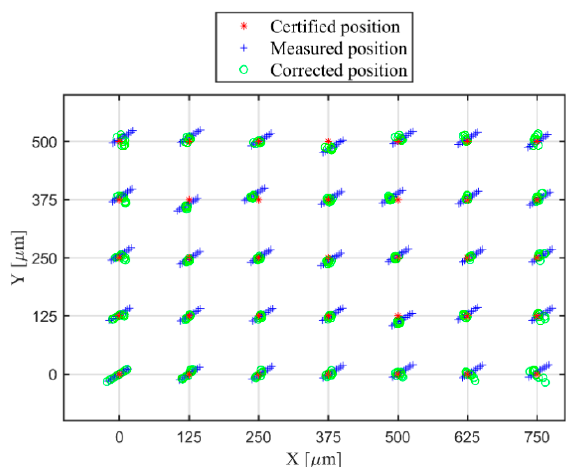
Figure 17. Comparison of the certified, measured, and corrected positions of the 10 simulations.